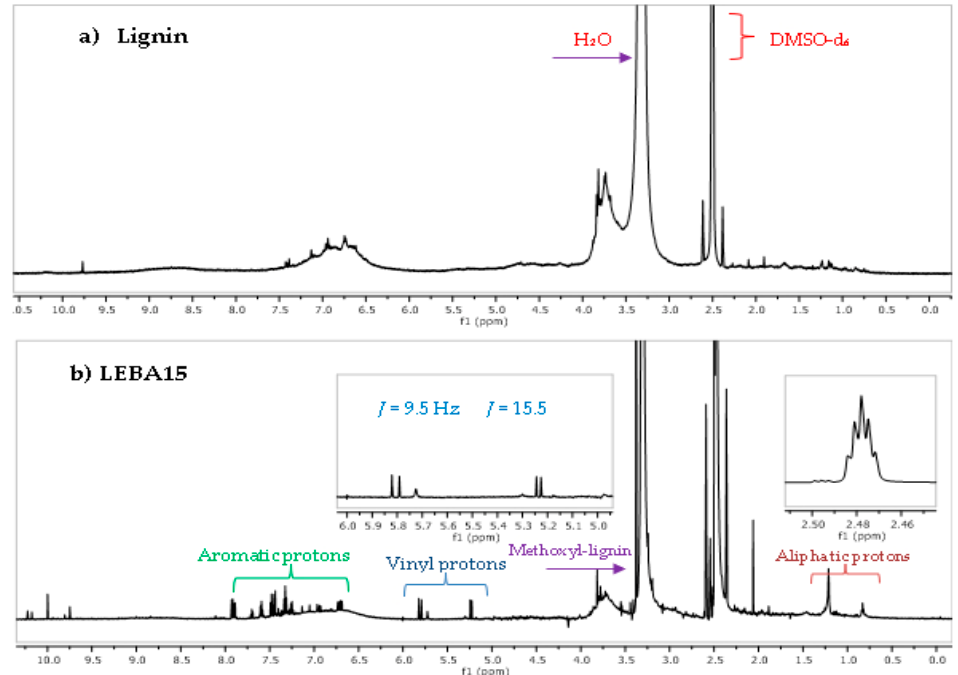
◦ C, 400 MHz) for: ( a ) Lignin and ( b ) 6 , 25